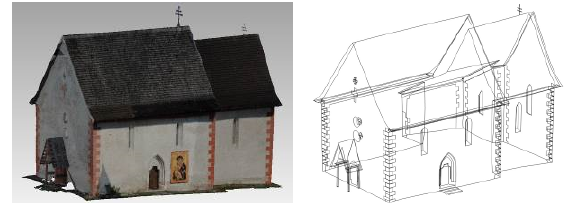
Figure 6. Polygonal and vector model of the church in Čerín